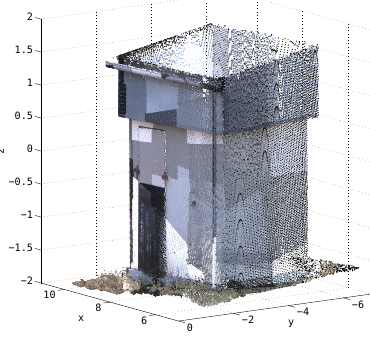
Figure 2: Point cloud of the material test module